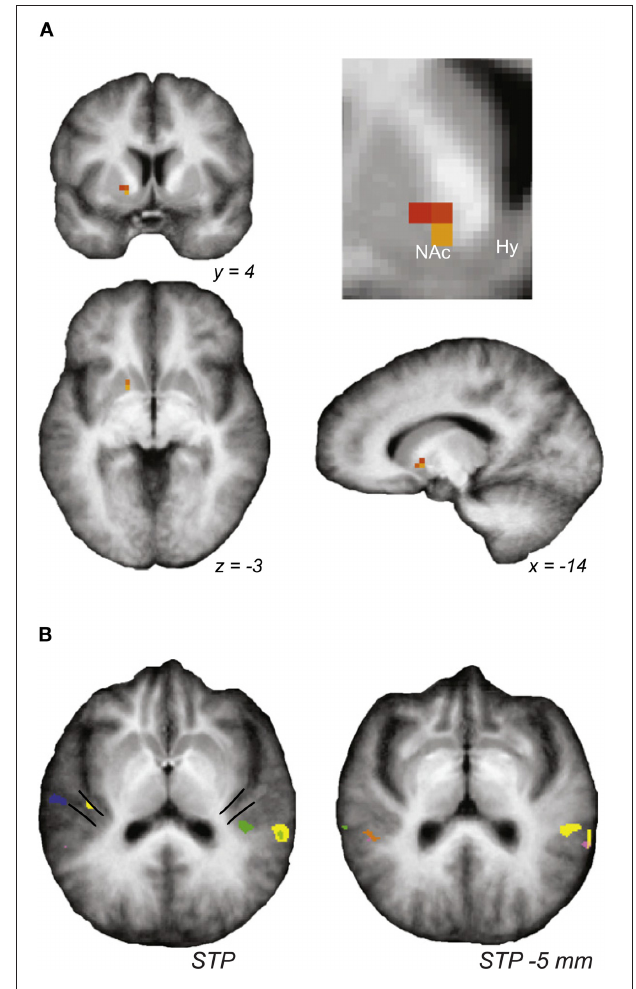
FIGURE 2 | Auditory and limbic brain centers exhibit sound-evoked hyperactivity. Stimuli matched for perceived tinnitus frequency evoked significantly higher activity, as measured by fMRI, in (A) the nucleus accumbens (NAc) and (B) medial Hershel’s gyrus (mHG), the presumed site of primary auditory cortex. Figure adapted from Leaver et al.